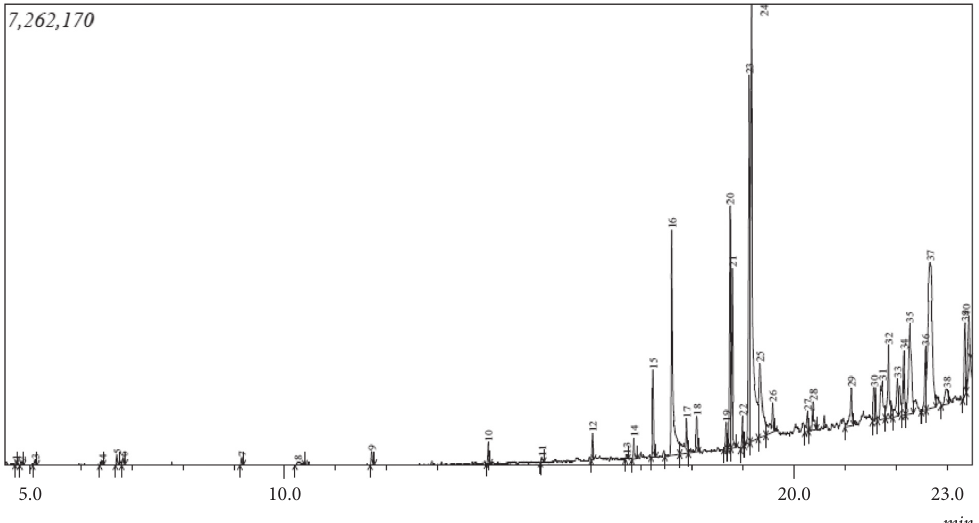
Figure 2: Chromatogram of essential oils of tamarind seeds extracted by Soxhlet